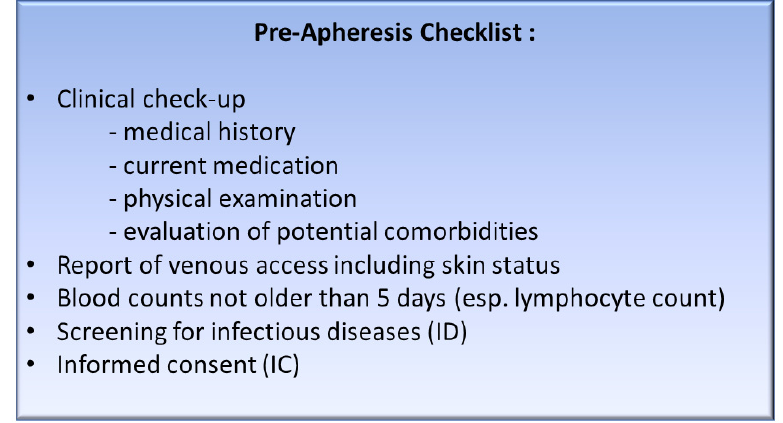
Figure 2. Checklist for requirements prior to leukapheresis. This figure displays an operational sequence description, analog to autologous or allogeneic cell therapy, as performed at the University Hospital of Heidelberg for patients prior to CAR-T cell apheresis.